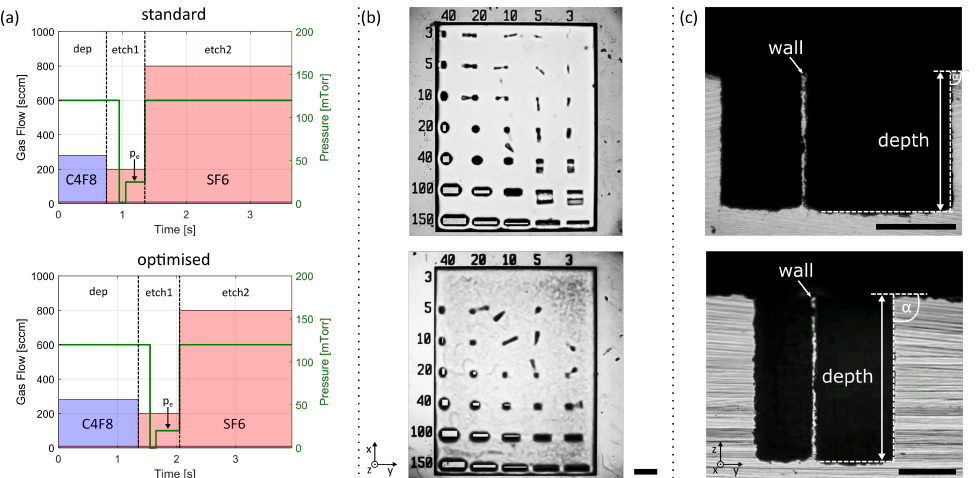
Figure 3. High aspect ratio etching of small structures. ( a ) Schematic of the standard three-step Bosch process parameters as provided by the supplier ( top ) and the optimised parameters ( bottom ). ( b ) Optical microscopy images of micron-sized pillars with 100µm height (z-direction), produced with the standard ( top ) and optimised ( bottom ) process parameters. Numbers on the top and the side correspond to the width (x-direction) and length (y-direction) of the structures, respectively. With our novel process, we achieved the production of a 40 × 10 × 100µm (x,y,z) pillar, which was impossible with the standard recipe. Scale bar corresponding to 150µm. ( c ) Optical microscopy pictures of a diced silicon wafer with two channels and a narrow wall in-between. The tranches were etched 186µm ( top ) and 277µm ( bottom ) deep into the silicon wafer. The narrow wall is 6.4 ± 0.2µm wide ( top ) and 8.4 ± 0.5µm wide ( bottom ). The channels have an etch angle of 89.83 ◦ . The etch angle for the optimised process was α = 89.6° ± 0.1° (see Supporting Figure S6). Scale bars corresponding to